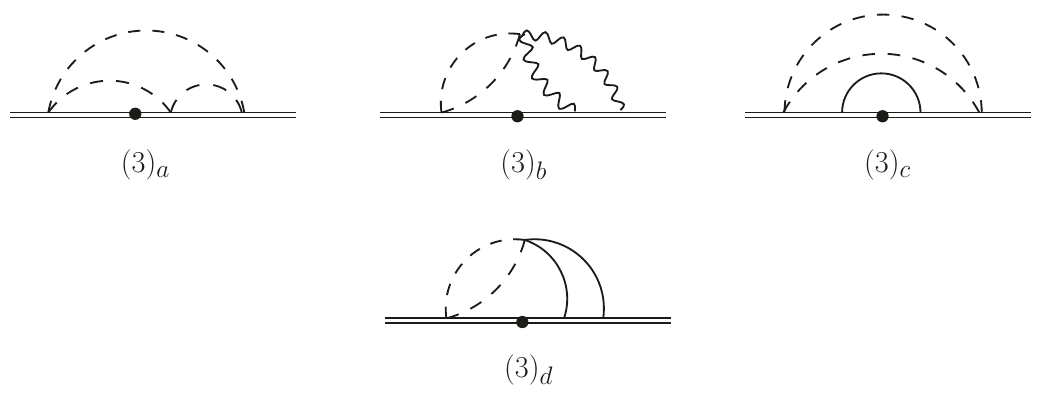
Figure 8 . Diagrams with scalar